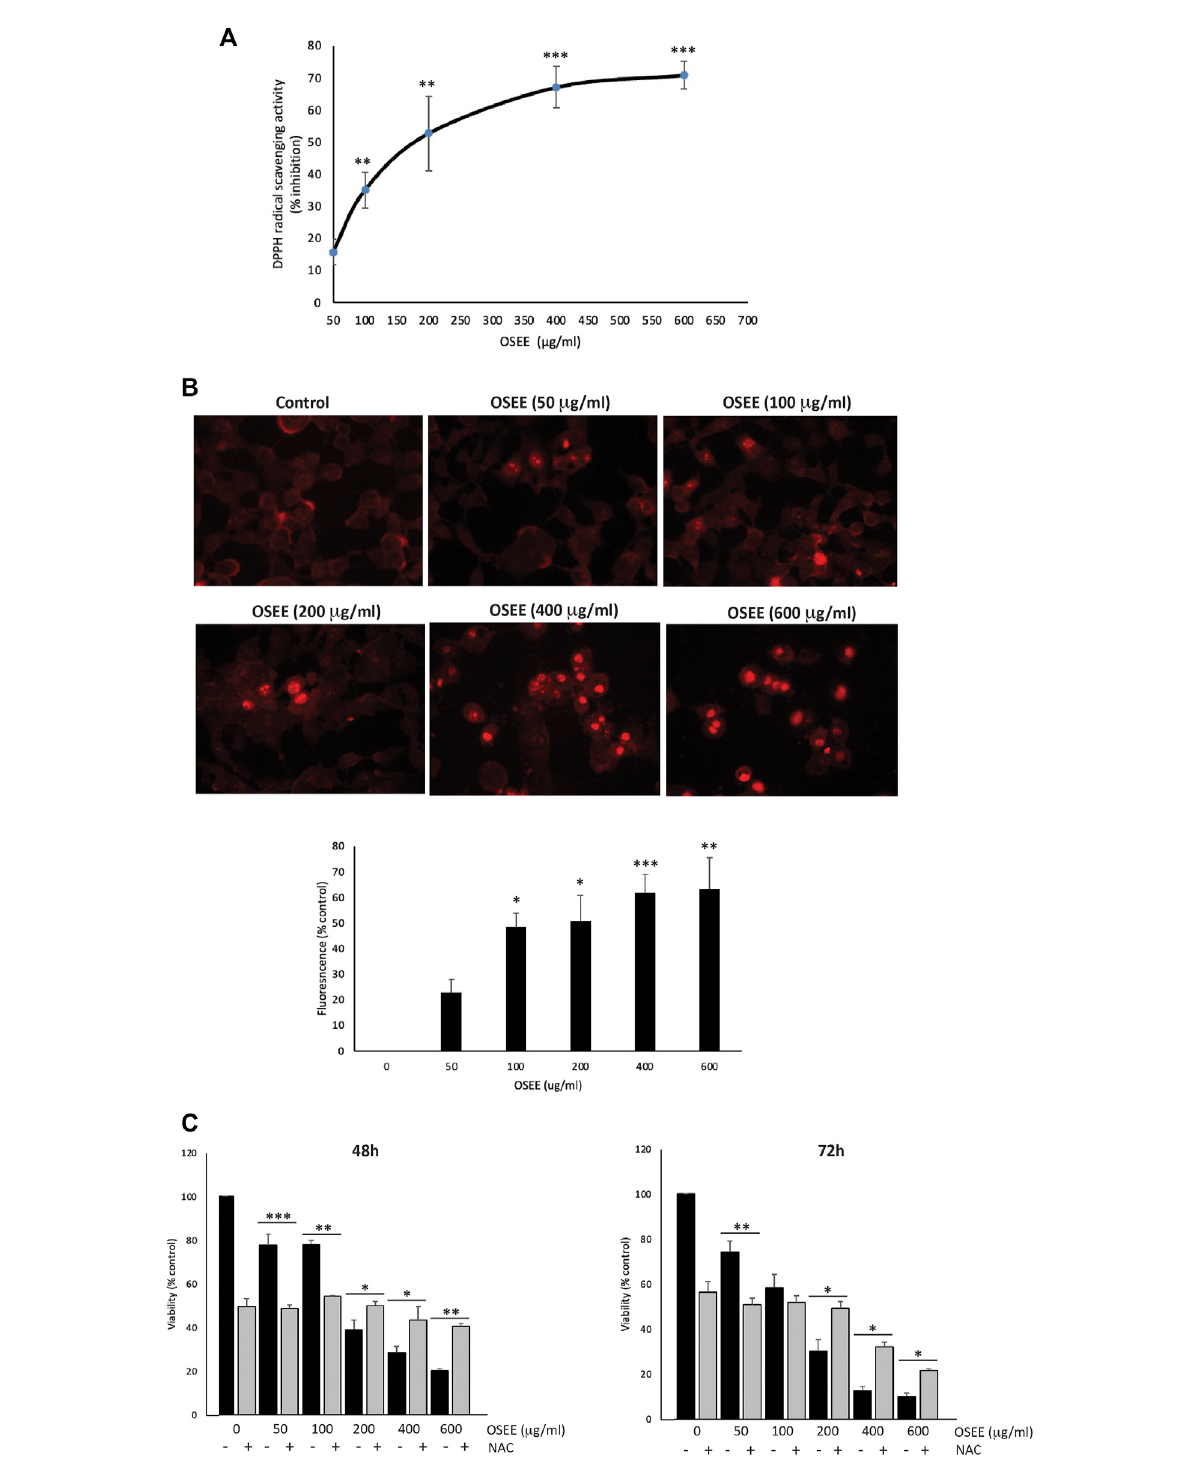
FIGURE 3 O. syriacum has remarkable antioxidant potential and can increase the generation of ROS in MDA-MB-231 cells. (A) The antioxidant activity of the indicated concentrations of OSEE was measured by 2,2-di-phenyl-1-picrylhydrazyl (DPPH) radical scavenging capacity assay as described in Materials and Methods. Data represent the means ± SEM of three independent experiments. (B) Fluorescent images of dihydroethidium (DHE)- stained MDA-MB-231 cells. Cells were treated with and without the indicated concentrations of OSEE for 24 h and stained with DHE, as indicated in Materials and Methods, to measure intracellular ROS production. (C) MDA-MB-231 cells were pre-treated with NAC (10 mM) for 30 min and thenwith OSEE attheindicated concentrations. Cellviability wasmeasured usingtheMTT assay attheindicated time points. OSEE-treated cells without NAC pre-treatment were used for comparison. Values represent the means ± SEM of three independent experiments performed in triplicates and expressed as percentage of vehicle-treated control cells (* p < 0.05, ** p < 0.005, *** p <